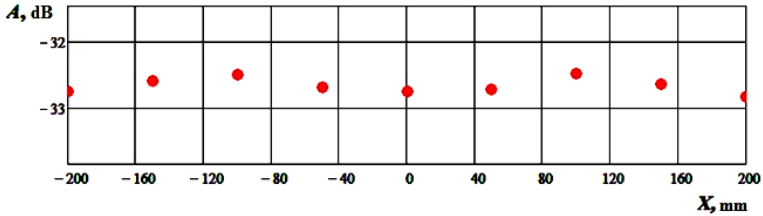
Fig. 3. Sample amplitude distribution of the digital antenna array.